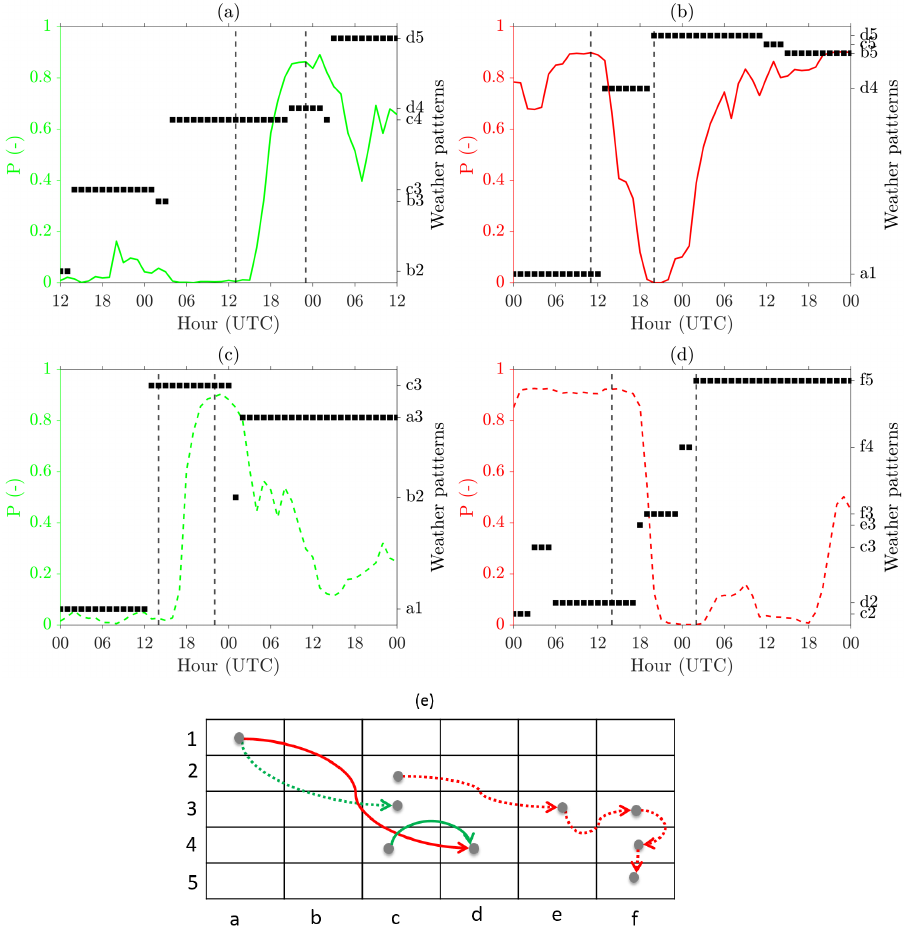
Figure 9. Strong wind power ramp cases and associated weather patterns: ( a ) R5 ( b ) R6 ( c ) R7 ( d ) R8, and ( e ) a sketch of the weather-pattern transitions for R5 (solid green line), R6 (solid red line), R7 (green dashed line) and R8 (red dashed line). R5–R8 periods are shown in Table 1. The vertical black dash lines in the ( a – d ) indicate the detected start and end time of the